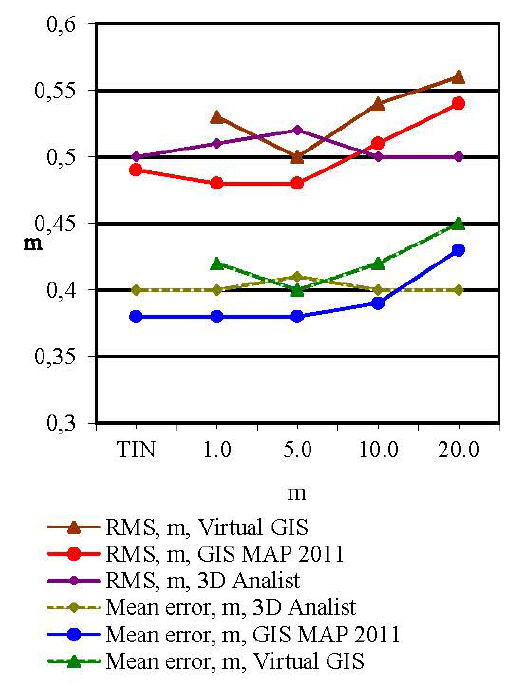
Figure 3. A diagram of the results of vertical positional accuracy estimation of control points located on the ground surface and at the bottom corners of construction for GIS “Map 2011”, Virtual GIS and 3D